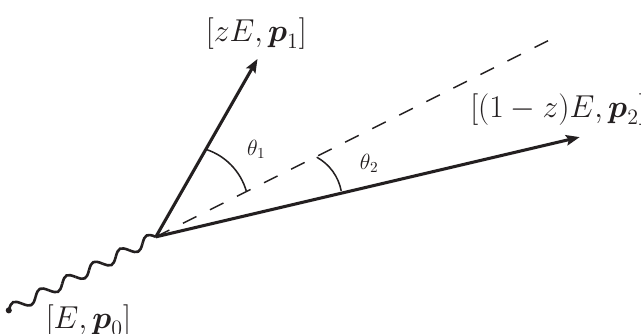
q ¯ q . A typical assumption is to consider that →